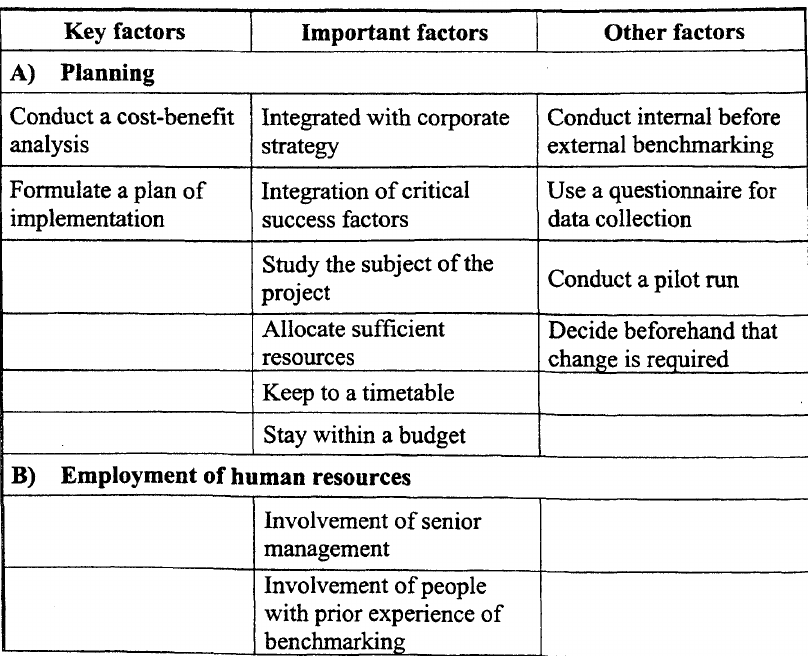
Table 1 - Summary of empirical